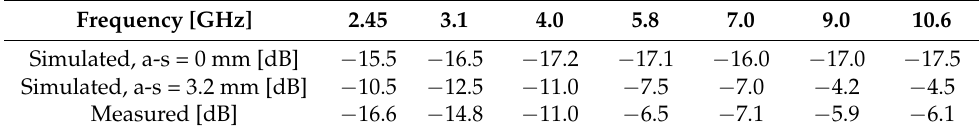
Table 3. Measured and simulated total efficiencies at different antenna-skin